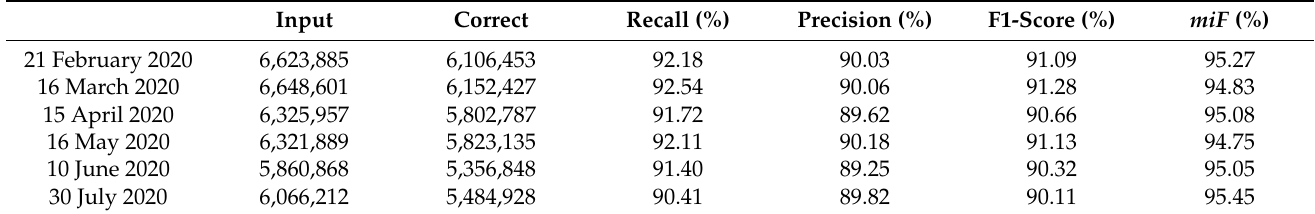
Table 6. Summary of the FCDN_CSM daytime predictions for six days’ data.